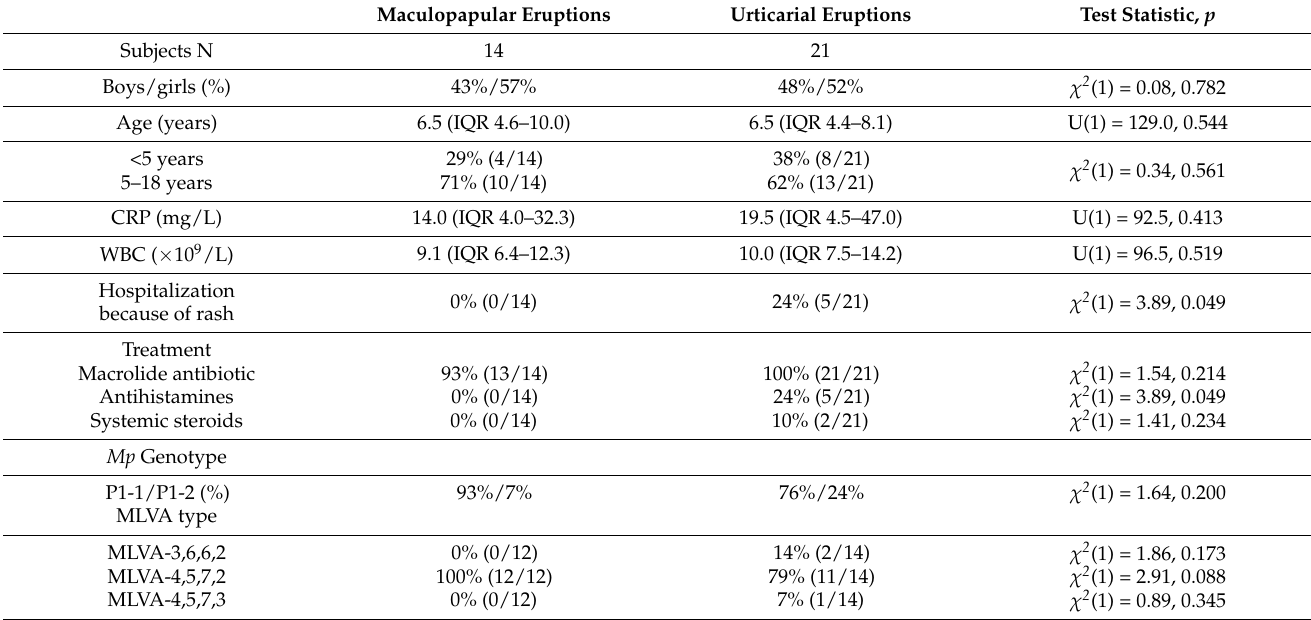
Table 3. Characteristics of patients with maculopapular and urticarial M. pneumoniae -induced cu- taneous disease. Data are presented as median (IQR) or as percentage (proportion of subjects). Significant differences ( p < 0.05) are highlighted in bold.